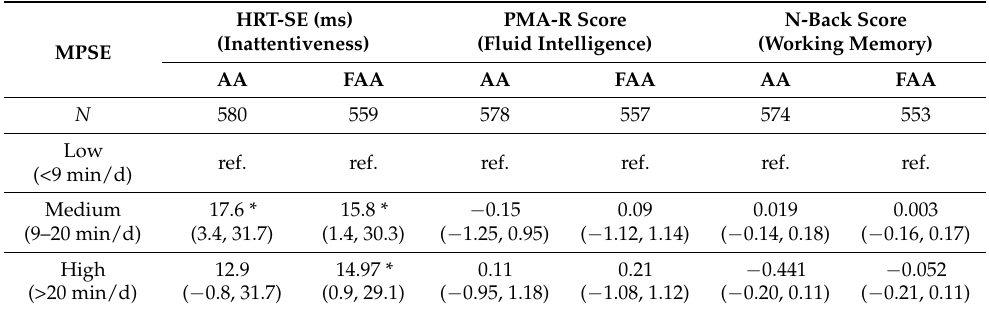
Table 4. Association between mobile phone screen exposure and cognitive outcomes, adjusting for intermediate